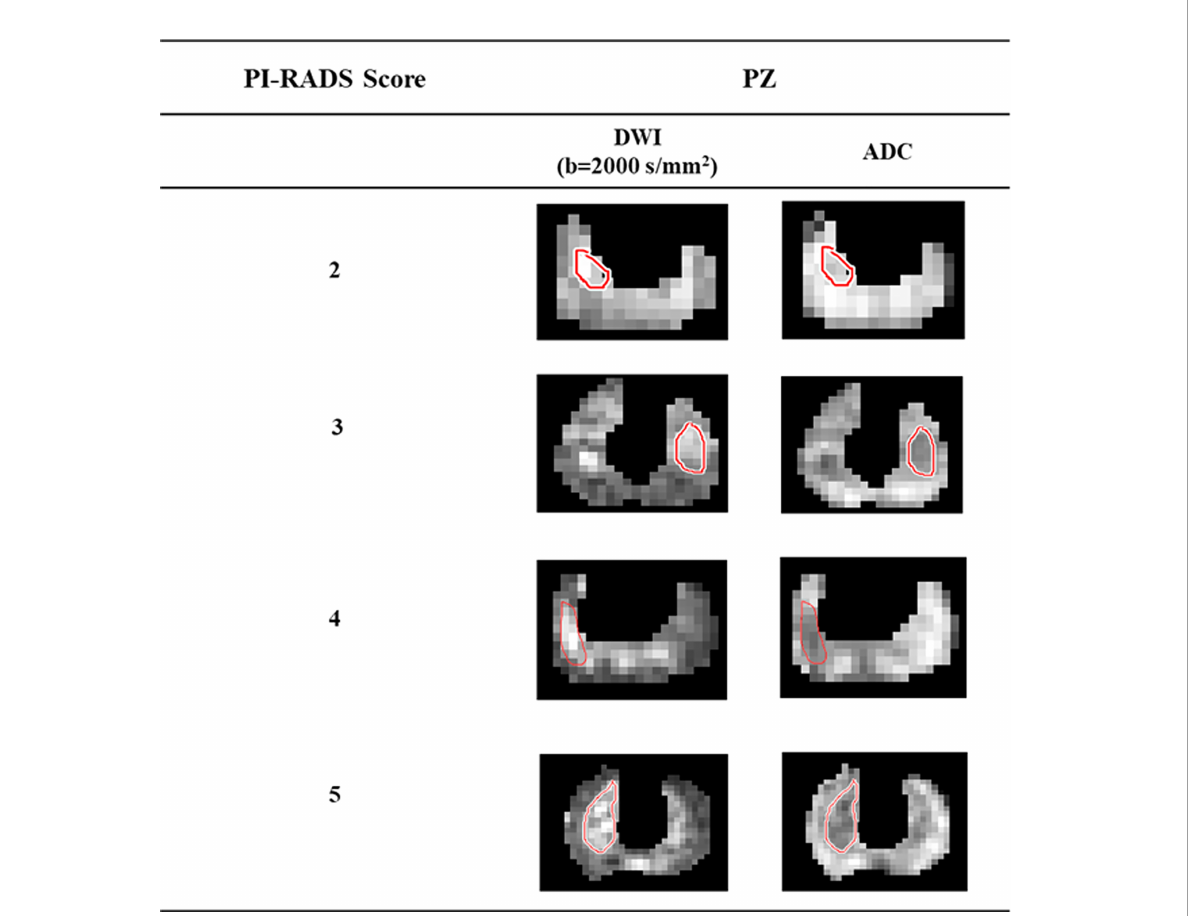
FIGURE 1 Lesion region of interests delineation from high b-value (b = 2000 s/mm 2 ) DWI and ADC of the representative patients with different PI-RADS scores 2 to